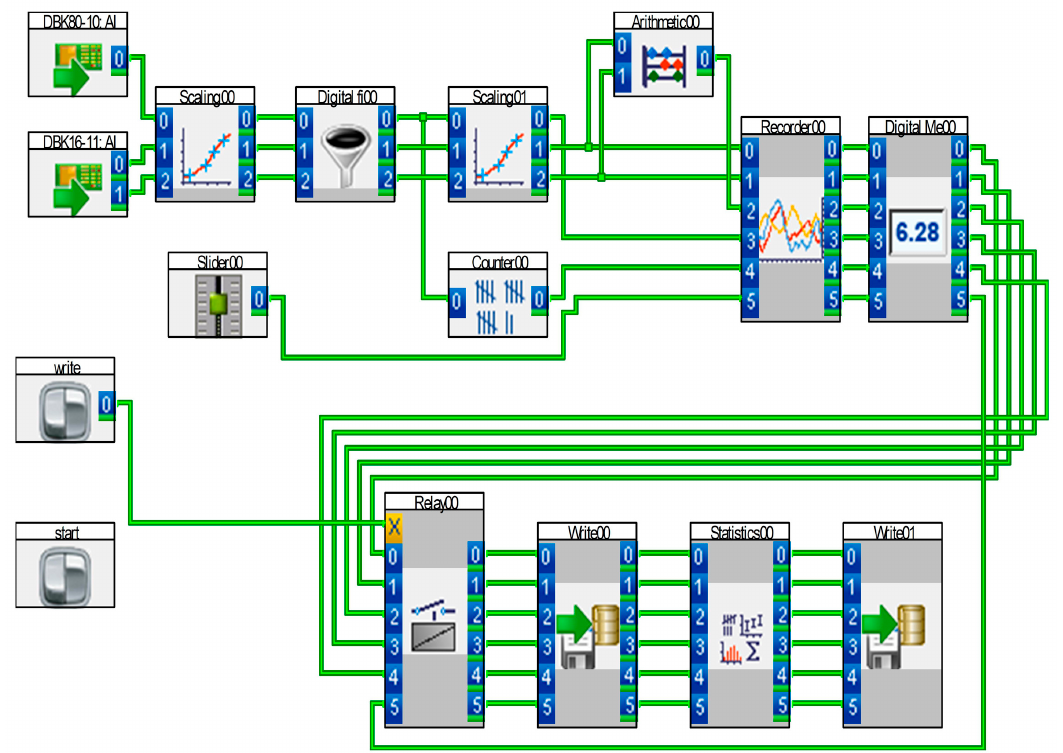
Figure 4. Diagram of program that controlled the Daqbook 2001 system.